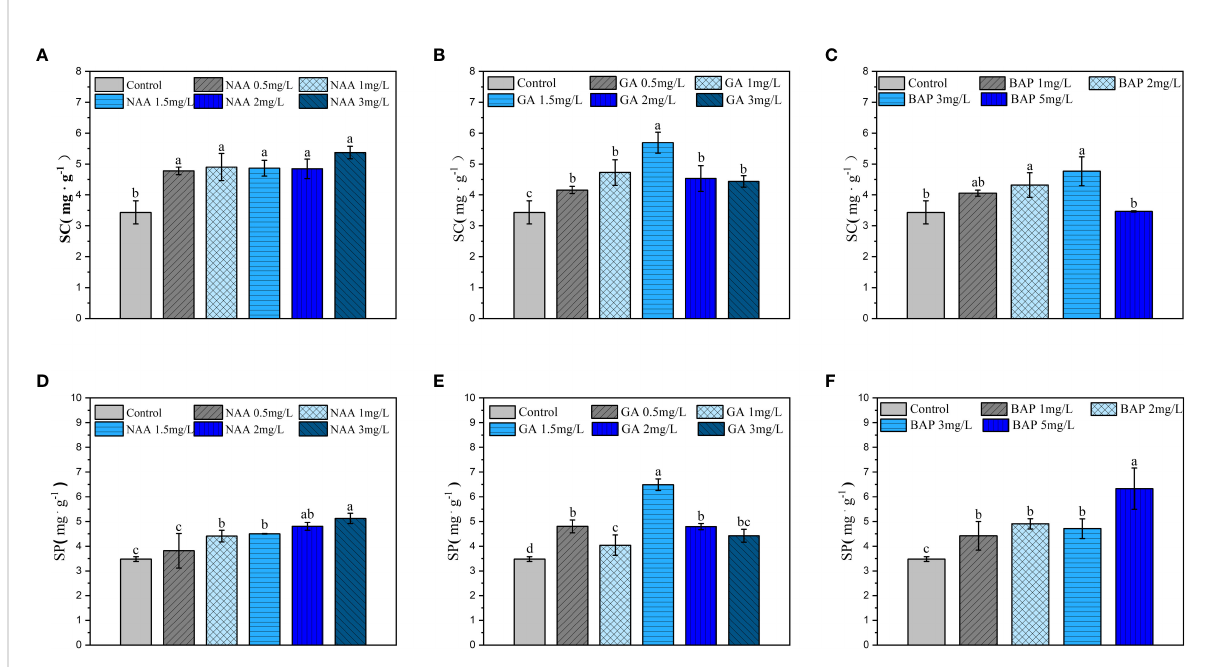
FIGURE 7 Effects of three exogenous hormones on the accumulations of soluble protein and carbohydrate in Sargassum fusiforme holdfasts. (A – C) : soluble protein contents in the holdfasts under different culture conditions; (D – F) : soluble carbohydrate contents in holdfasts under different culture conditions. Values are mean ± standard deviation (n = 3). Different letters indicate signi fi cant differences between different culture conditions (p <